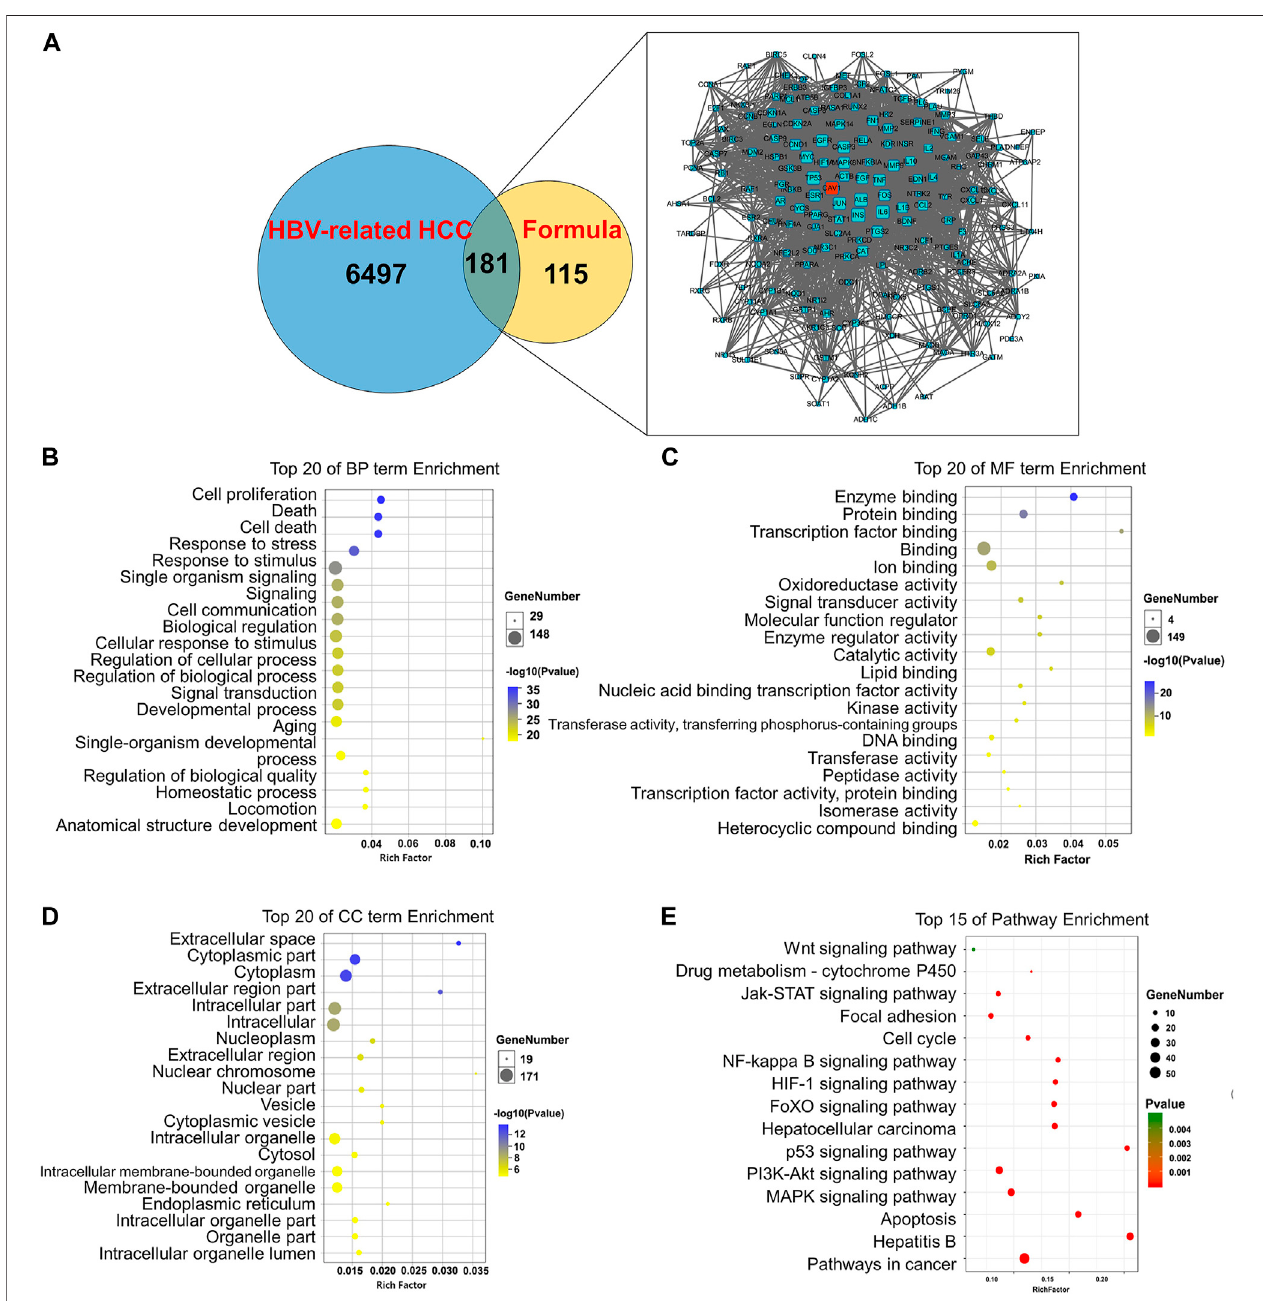
FIGURE5| Establishmentofingredient-target-diseasenetworkofCPinHBV-associatedHCC. (A) TheVenndiagramshowedatotalof181putativeCPtargetsfor HBV-associatedHCCwereextracted.CAV-1wasoneofthelargestnodesbasedonthe “ Degree > 100 ” . (B) Pathwayenrichmentanalysisofthe181hubgenes. (B) The top 20 terms of BP enrichment (C) The top 20 terms of MF enrichment. (D) The top 20 terms of CC enrichment (E) Pathway enrichment analysis of the DEGs.